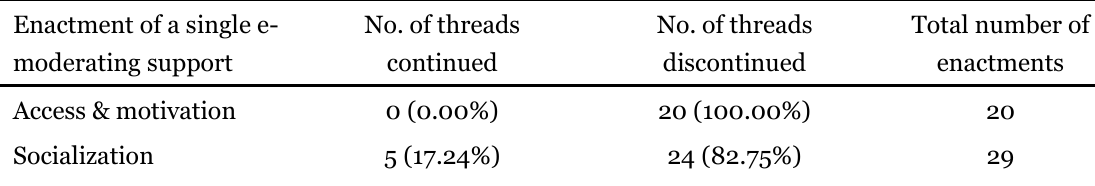
Effect of Single E-Moderating Support on Thread Termination and Development Enactment of a single e- moderating